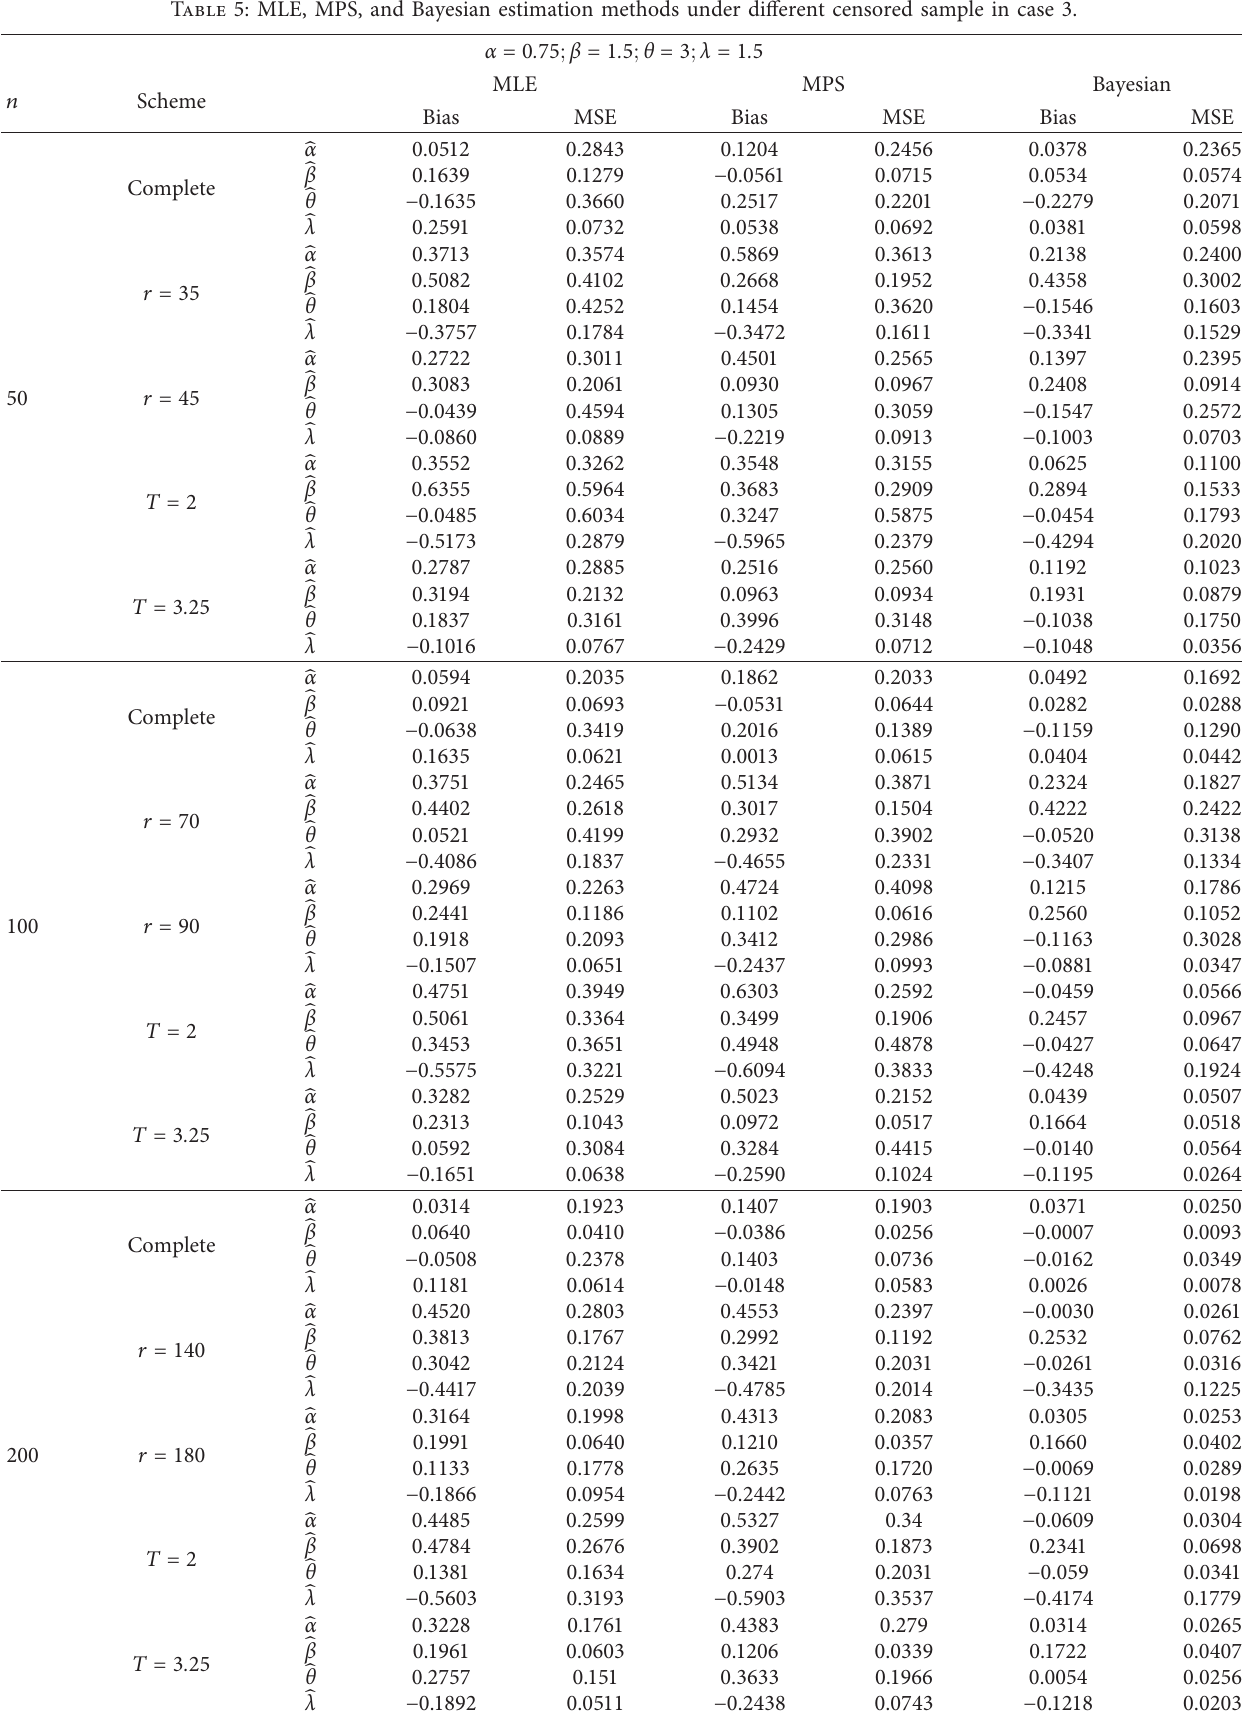
Table 5: MLE, MPS, and Bayesian estimation methods under different censored sample in case